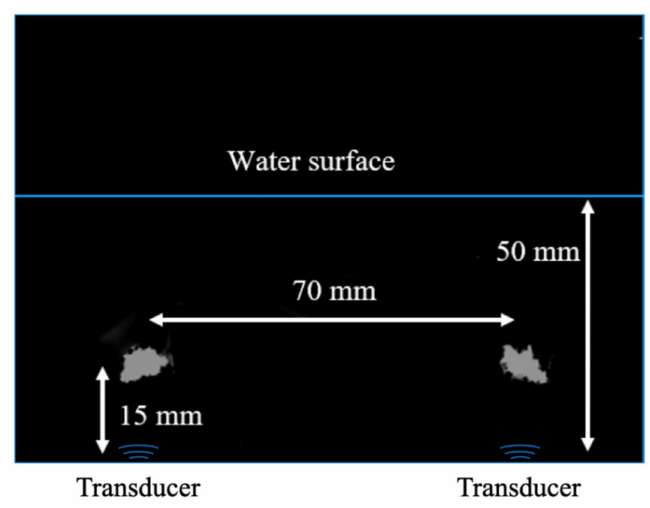
Figure 4. Aluminum foil erosion at 165 kHz for 5 min.